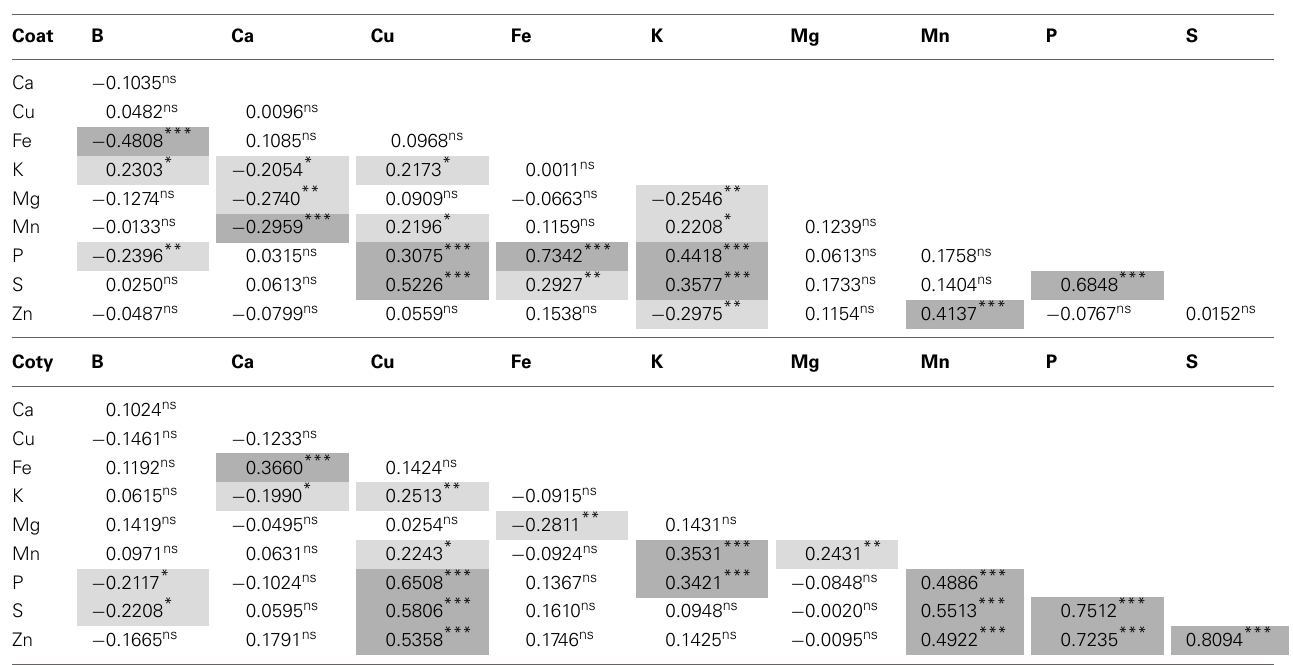
Table 3 | Pearsons correlation coefficients and significance for ten minerals 1 evaluated by inductively coupled plasma (ICP) analysis for seed coat and cotyledonary tissue in the advanced backcross population of common beans.